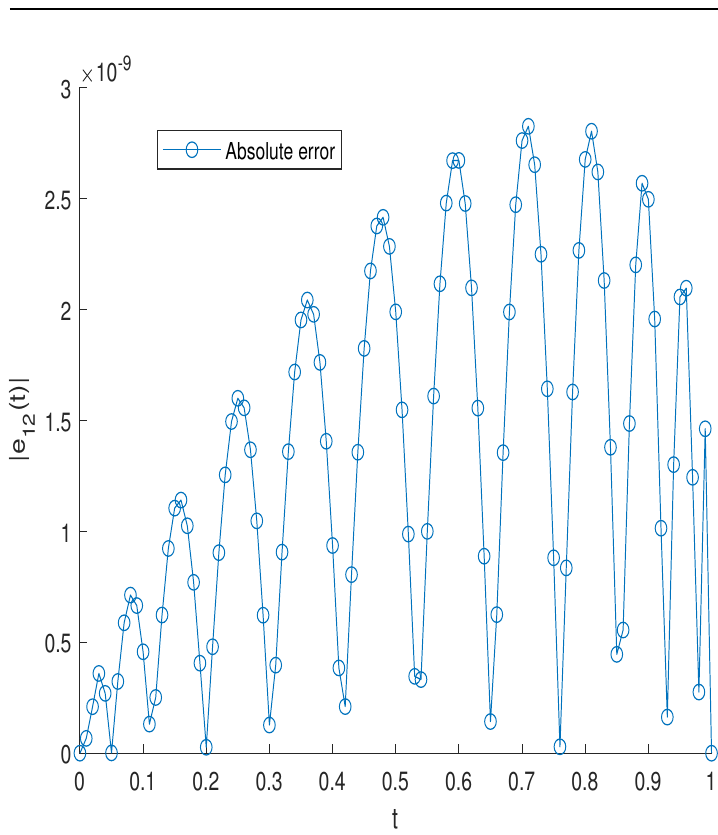
Figure 11. The absolute error for Example 5, for N =